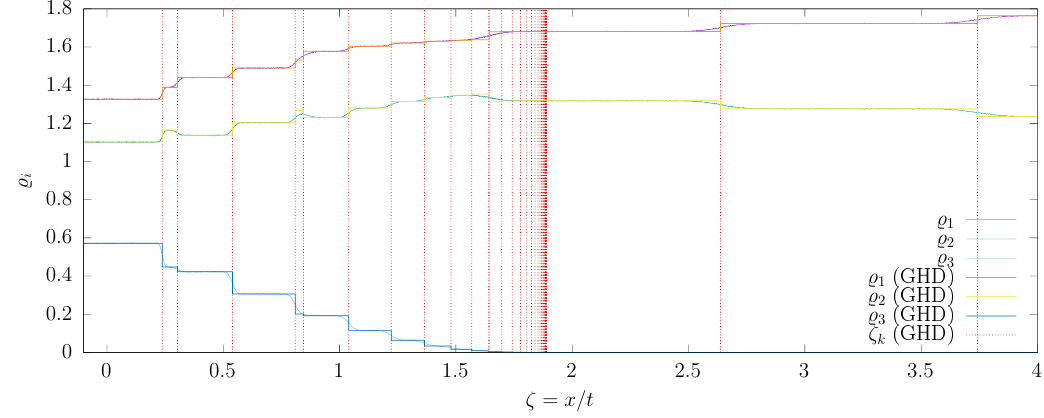
Figure 5: Densities (cid:37) i =1 , 2 , 3 of boxes with the entry i , as a function of ζ = x/t for t = 1000 and for the T (1) dynamics. Note that by construction (cid:37) 1 + (cid:37) 2 + (cid:37) 3 = 3 , l =100 since each site contains 3 boxes (one in the tableau B 1 , 1 and two in the tableau B 2 , 1 ). The vertical red dotted line indicate the locations ζ ( k ) of the steps between the different plateaux, as predicted by GHD. The orange, yellow and blue lines are (cid:37) 1 , (cid:37) 2 and (cid:37) 3 from GHD (at t = ). The initial state is defined by the following ∞ fugacities in the left half: z 1 ,L = 1 z 2 ,L = 0 . 7 and z 3 ,L = 0 . 3 . The right half is initially in the vacuum state. A large number of very narrow plateaux are observed 1 . 88708 . Note that additional plateaux are to accumulate in the vicinity of ζ c (cid:39) present for ζ > 4 (not shown) and the system is still not in the vacuum state at the right of the figure (contrary to Fig. 6). Parameters of the simulations: system size L = 300000 and number of random initial conditions N = 300000 . samples